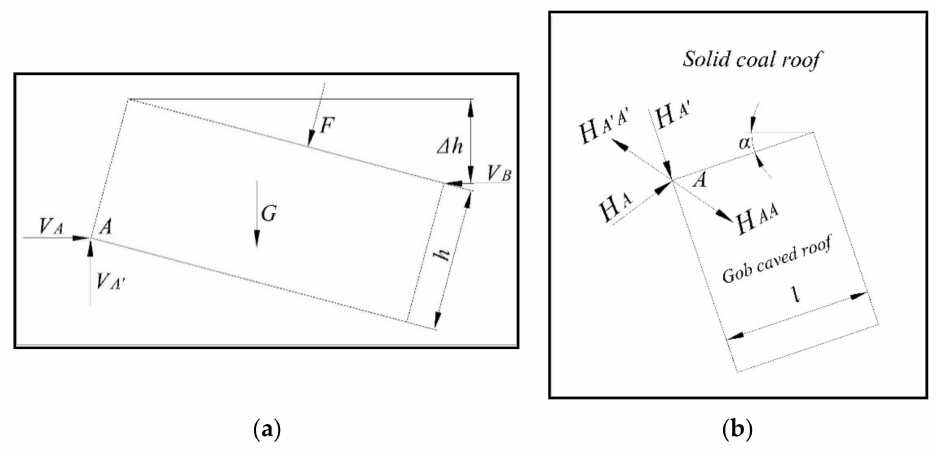
Figure 6. Mechanical model of key block B: ( a ) front view; ( b ) vertical